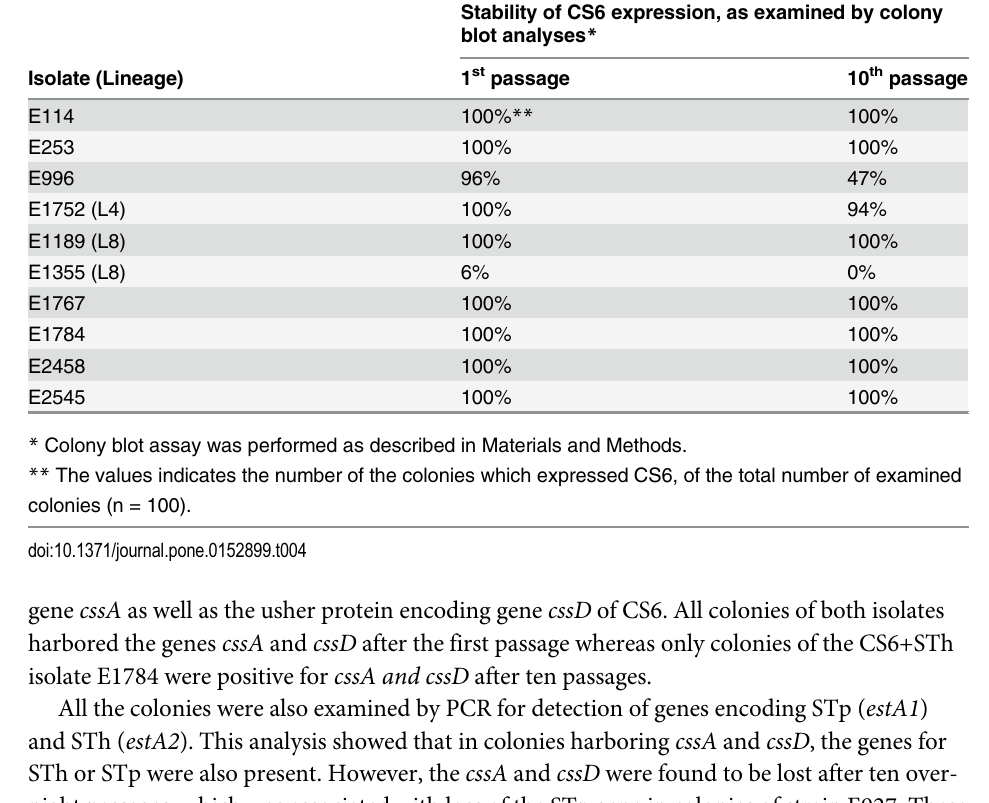
Stability of CS6 expression, as examined by colony blot analyses